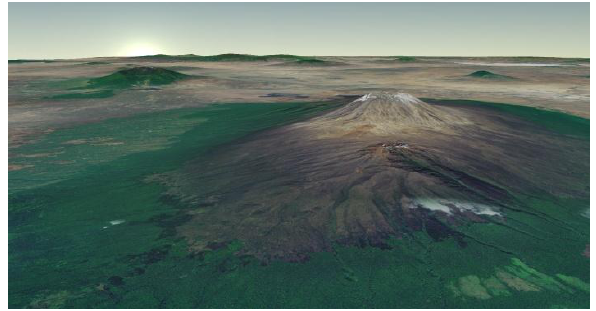
Figure 2 - Realistic earth globe visualisation